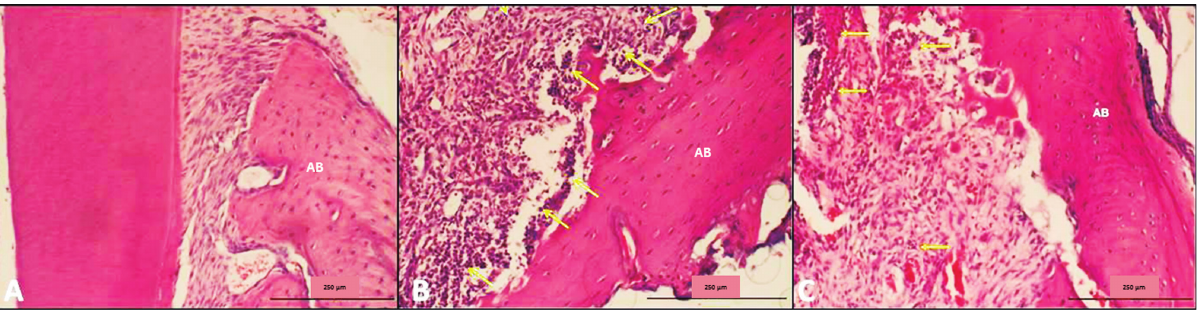
AB=alveolar bone; NL=non-ligated; LO=ligature only; S=ligature and treated with Figure 2- The histological images of each experimental group. A- The histological images of NL group showing normal periodontium (100x magnification); B- The histological images of LO showing intense inflammatory cell infiltrate, dilated blood vessels, and osteoclasts in their Howship’s lacunae with multiple resorption foci (100x magnification); C- The histological images of S showing moderate inflammatory cell infiltrate in periodontal ligament and osteoclasts in their Howship’s lacunae with multiple resorption foci. Yellow arrows show inflammatory cells (100x magnification)